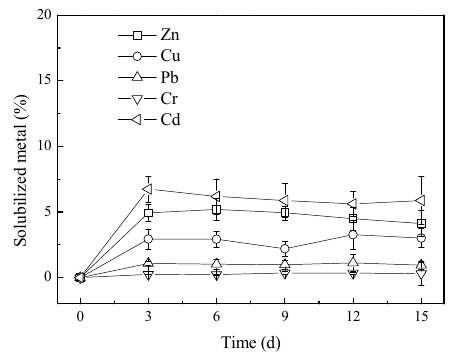
Figure A1. Heavy metals solubilization during bioleaching without sulfur.